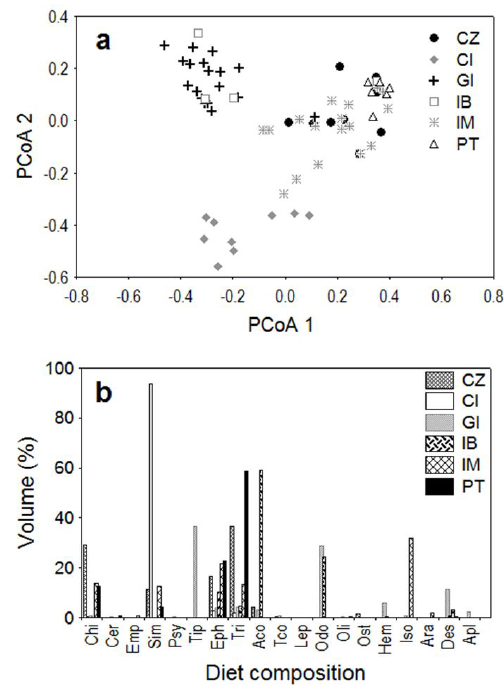
Figure 1. Diet data ordination (using the first two axes of PCoA, that explained 29% of the data variance) (a), and diet composition (b) of fish species sampled in the Água Queçaba stream. CZ= C. zebra ; CI= C. iheringi ; GI =G. inaequilabiatus; IB = I. borodini ; IM= I. mirini ; PT= P. tenebrosa ; Chi= Chironomidae; Cer= Ceratopogonidae; Emp= Empididae; Sim= Simuliidae; Psy= Psychodidae; Tip= Tipulidae; Eph= Ephemeroptera; Tri= Trichoptera; Aco= aquatic Coleoptera; Tco= terrestrial Coleoptera; Lep= aquatic Lepidoptera; Odo= Odonata; Oli= Oligochaeta; Ost= Ostracoda; Hem= Hemiptera; Iso= Isopoda; Ara= Araneae; Des= detritus/sediment; Apl= aquatic plants. Acta Limnologica Brasiliensia, 2019, vol. 31, e7